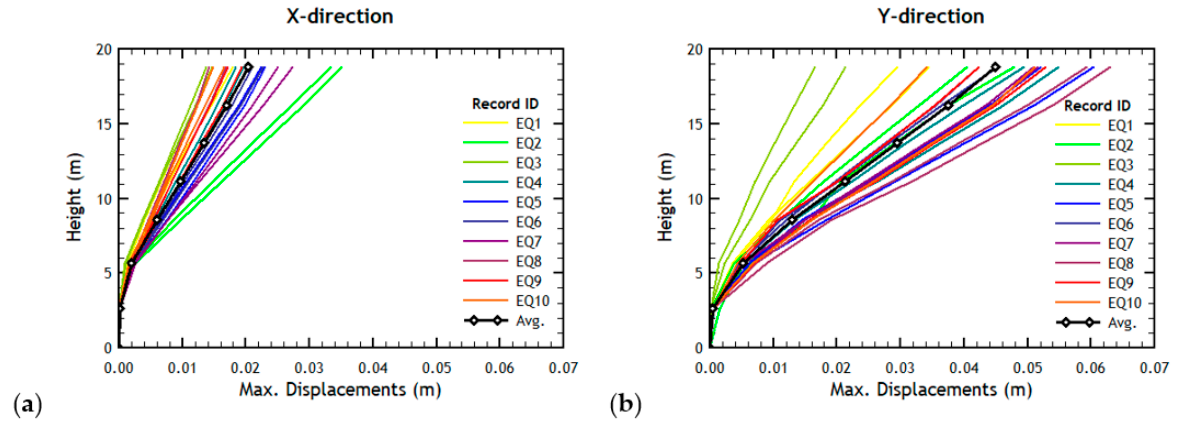
Figure 13. Maximum displacements in ( a ) X-direction and ( b ) Y-direction, as obtained from NLTHA for the records of Table 3.